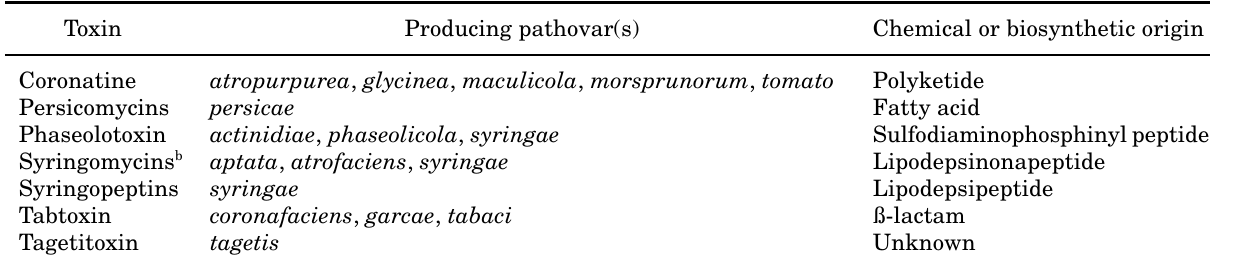
Table 8. Phytotoxins produced by Pseudomonas syringae pathovars a